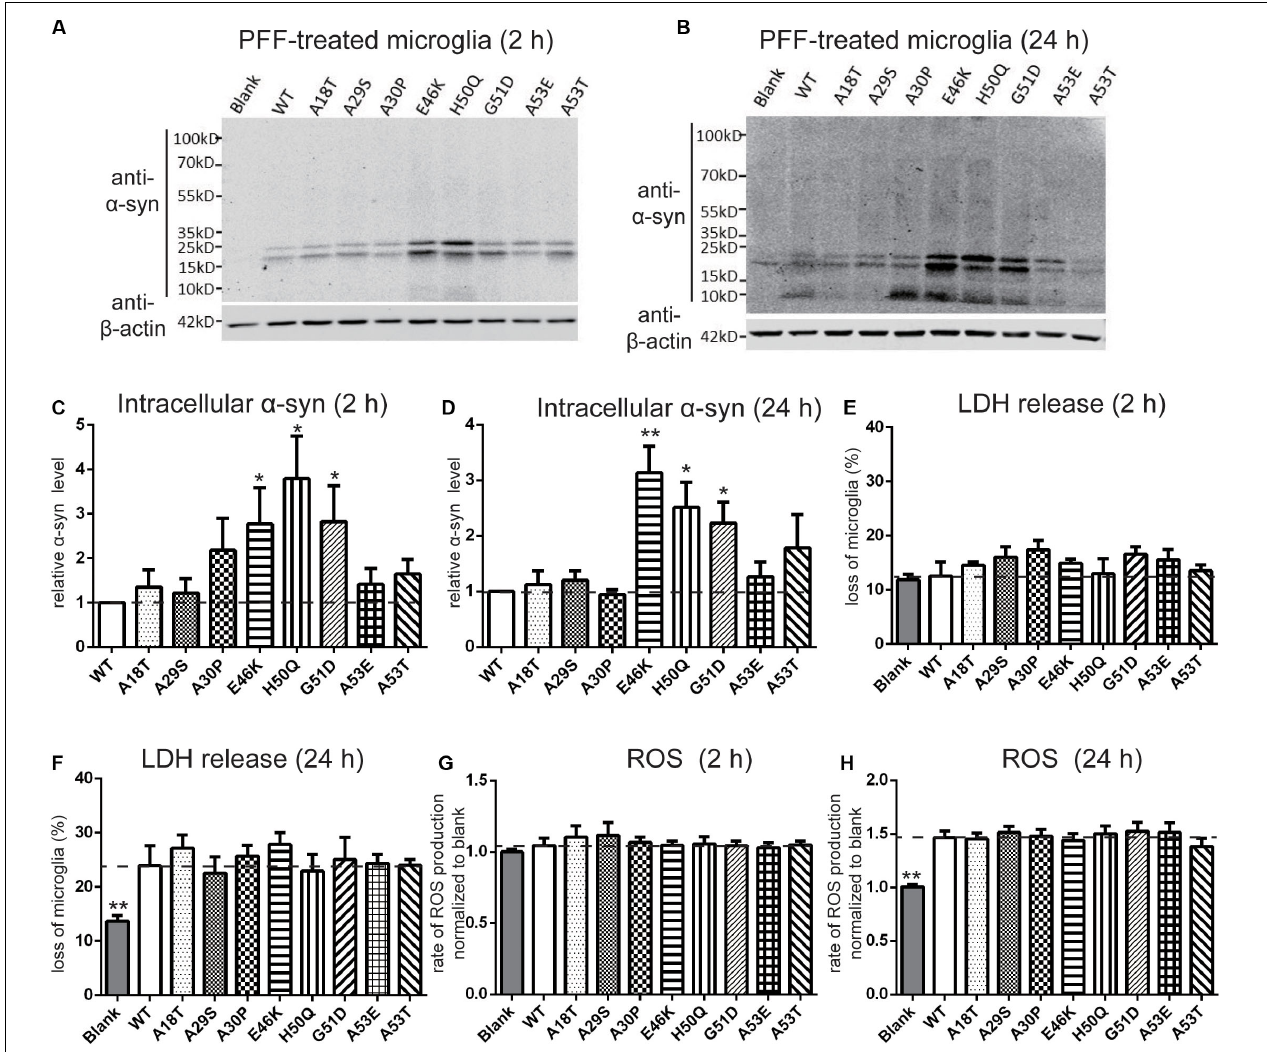
FIGURE 5 | Effects of pathogenic mutations on the intracellular α -syn levels and cytotoxicity of extracellular PFF treatment in primary microglia. Microglia were treated with 1 µ M sonicated WT or pathogenic mutant PFFs at 37 ◦ C for 2 h (A,C,E,G) and 24 h (B,D,F,H) . (A–D) Immunoblots and analysis of intracellular α -syn. (E,F) Cell viability assessed by LDH release. (G,H) Oxidative stress assessed by ROS assays. Mean ± SEM; * P < 0.05, ** P < 0.01, one-way ANOVA followed by Dunnett’s test compared to WT; n = 3 independent